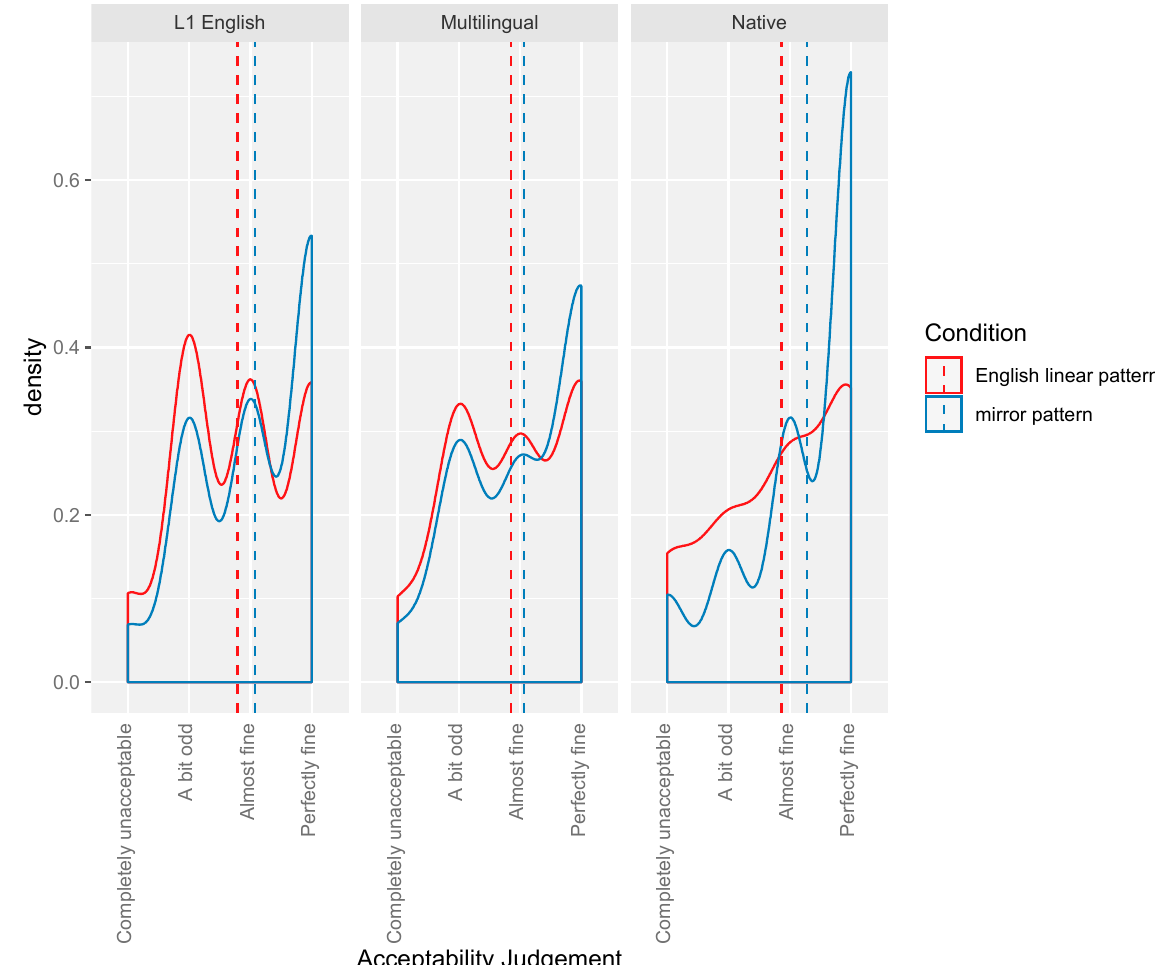
Figure 4. Density plot of acceptability judgements for two-adjective sequences given speaker group (L1 English, Multilingual, Native).